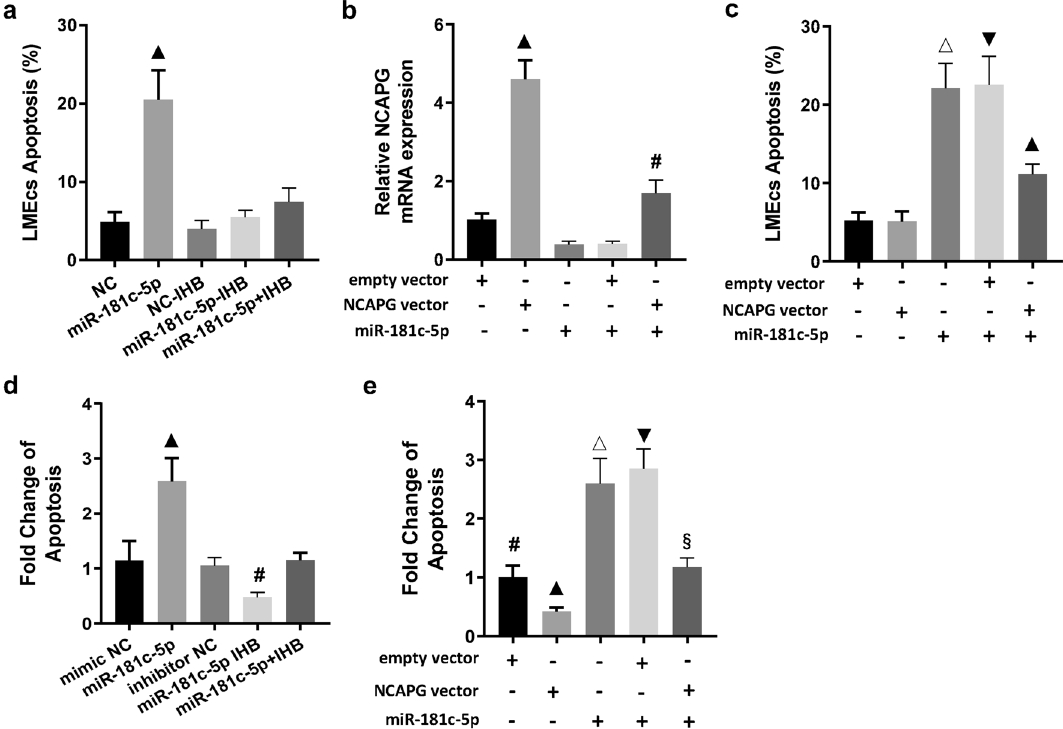
Figure 4. MiR-181c-5p promoted hyperoxia-induced apoptosis of LMECs by inhibiting the expression of its target gene NCAPG. ( a ) Comparison of apoptosis of LMECs treated with miR-181c-5p mimic (miR-181c-5p) or inhibitor (IHB) and the corresponding negative control sequences (NC, NC-IHB). ▲ : p < 0.001 versus all other groups. ( b ) Comparison of expression levels of NCAPG mRNA in LMECs with different treatments. ▲ : p < 0.001 versus all other groups; # : p < 0.01 versus all other groups. ( c ) Comparison of apoptosis of LMECs with different treatments. △ : p < 0.001 versus all other groups except for miR-181c-5p + empty vector group; ▼ : p < 0.001 versus all other groups except for miR-181c-5p group; ▲ : p < 0.001 versus all other groups. ( d ) Relative changes of apoptosis of hyperoxia-treated LMECs transfected with miR-181c-5p mimic (miR-181c-5p) or inhibitor (IHB) and the corresponding negative control sequences (NC, IHB-NC). ▲ : p < 0.001 versus all other groups; #: p < 0.01 versus all other groups. ( e ) Relative changes of apoptosis of hyperoxia-treated LMECs transfected with miR-181c-5p or different vectors. #: p < 0.01 versus all other groups; ▲ : p < 0.001 versus all other groups; △ : p < 0.001 versus all other groups except for miR-181c-5p + empty vector group; ▼ : p < 0.001 versus all other groups except for miR-181c-5p group; § : p < 0.001 versus all other groups except for empty vector group. Data are presented as mean ± SEM. One-way ANOVA analysis with Tukey’s post hoc test was used for statistical and shRNA vector and their corresponding empty vectors were constructed and transfected into LMECs alone or with miR-181c-5p. The results showed that lnc-DLEU2 expression vector significantly blocked the inhibitory effect of miR-181c-5p on the expression of its target gene NCAPG at the mRNA and protein levels, as well as the pro-apoptotic effect of miR-181c-5p on LMECs, while the shRNA vector of lnc-DLEU2 had the opposite effect and empty vector had no significant effect (Fig. 5c–e). In addition, the transfection of expression vector or shRNA vector of lnc-DLEU2 all had no significant effect on the expression level of miR-181c-5p in LMECs (Fig. 5f). These results indicate that lnc-DLEU2 suppressed the inhibitory effects of miR-181c-5p on its target NCAPG as a sponge of miR-181c-5p. Lnc‑DLEU2 inhibited the LMEC apoptosis induced by hyperoxia through a ceRNA network consisted of DLEU2, miR‑181c‑5p and NCAPG. To further elucidate the relationship among miR- 181c-5p, NCAPG and lnc-DLEU2 in endothelial injury caused by hyperoxia, lnc-DLEU2 expression vector and shRNA vector or their corresponding empty vectors were transfected into hyperoxia-treated LMECs. The results showed that lnc-DLEU2 expression vector remarkably attenuated the down-regulation of NCAPG mRNA and protein caused by hyperoxia, while lnc-DLEU2 shRNA vector had the opposite effect on NCAPG expression, and the empty vector had no significant effect on NCAPG expression (Fig. 6a,b). Meanwhile, the lnc-DLEU- 2expression vector could markedly attenuated hyperoxia-induced apoptosis of LMECs, while the lnc-DLEU2 shRNA vector had the opposite effect, and the empty vector has no significant effect (Fig. 6c). Additionally, miR-181c-5p mimic transfection significantly reduced the inhibitory effect of lnc-DLEU2 expression vector on hyperoxia-induced apoptosis of LMECs, while miR-181c-5p inhibitor enhanced this effect (Fig. 6d). Fur- thermore, the siRNA of NCAPG dramatically reduced the inhibitory effect of lnc-DLEU2 expression vector on